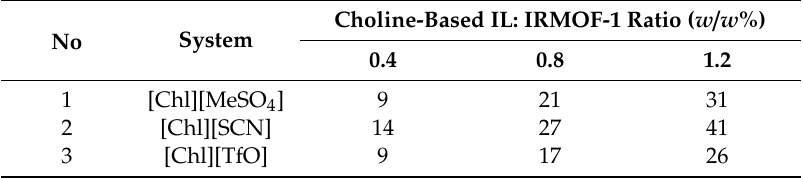
Figure 1. Molecular structures of cation [Chl] + and three anions ([MeSO 4 ], [SCN], and [TfO] − ) of ionic liquids (ILs) to be incorporated inside IRMOF-1. Table 1. The number of ILs inside the choline-based ILs/IRMOF-1 with different weight ratios.